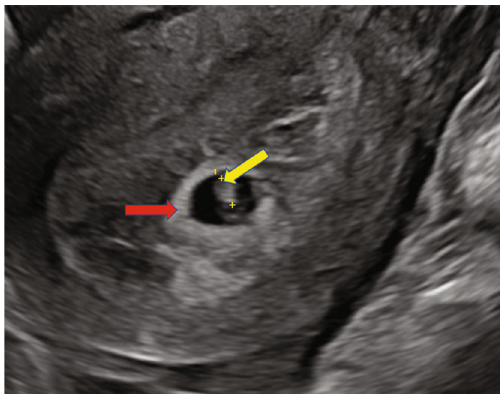
Figure 1: Longitudinal transvaginal ultrasound demonstrates an intrauterine gestational sac (red arrow) with a fetal pole (yellow arrow). Crown rump length measures 0.37 cm which correlates to the gestational age of 5 weeks and 5 days. Fetal heart rate was 128 beats per minute.